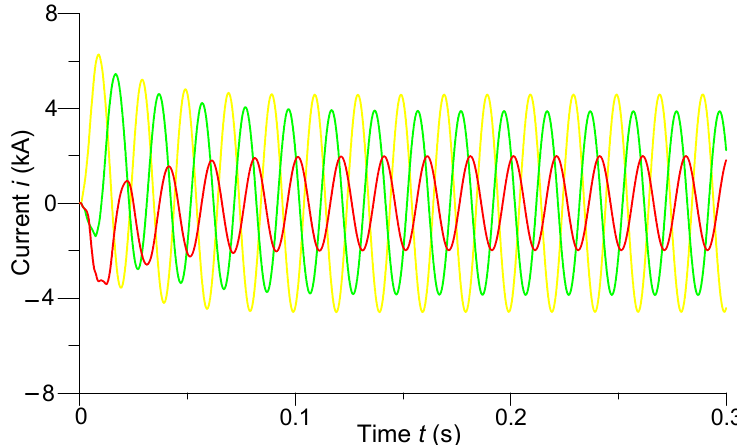
Figure 11. Transient processes of phase currents in the middle of the line.